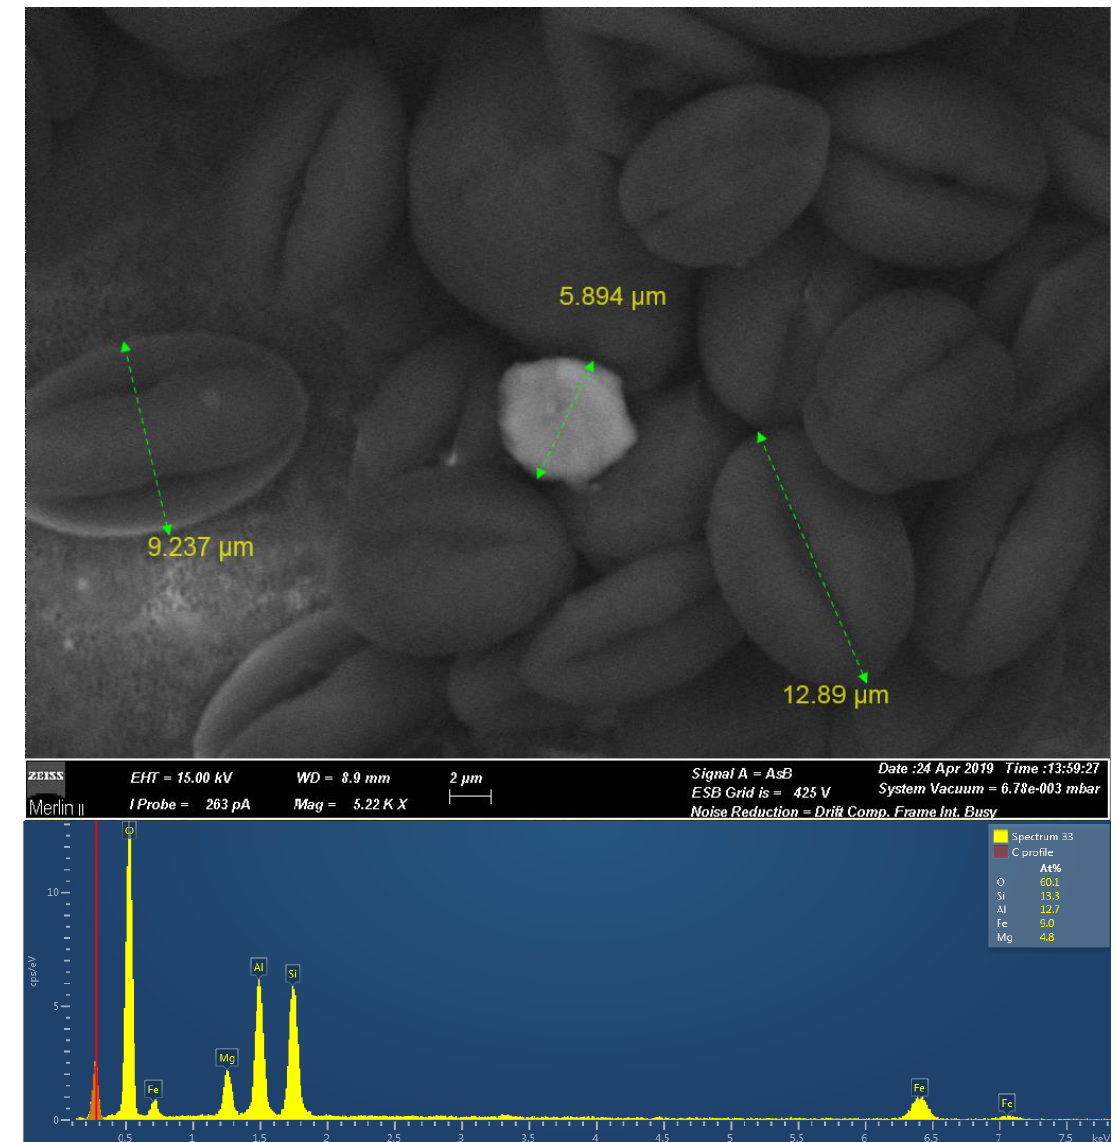
Figure 5. FESEM micrographs in compositional contrast (Backscattered electrons) of the pigment, including a cordierite crystal (the brighter area) in a high-density pollen matrix.